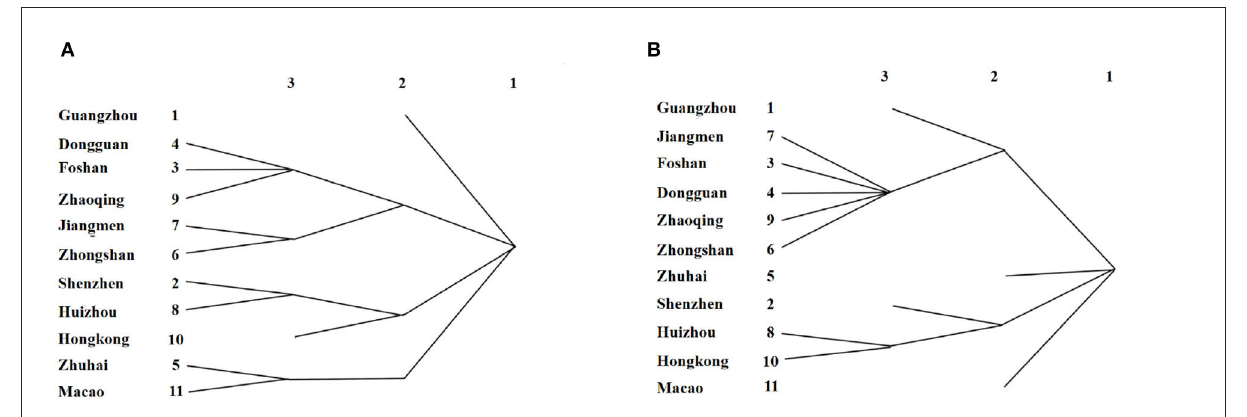
FIGURE8 Cohesive subgroups of GBA in (A) 2010-2019 and (B)